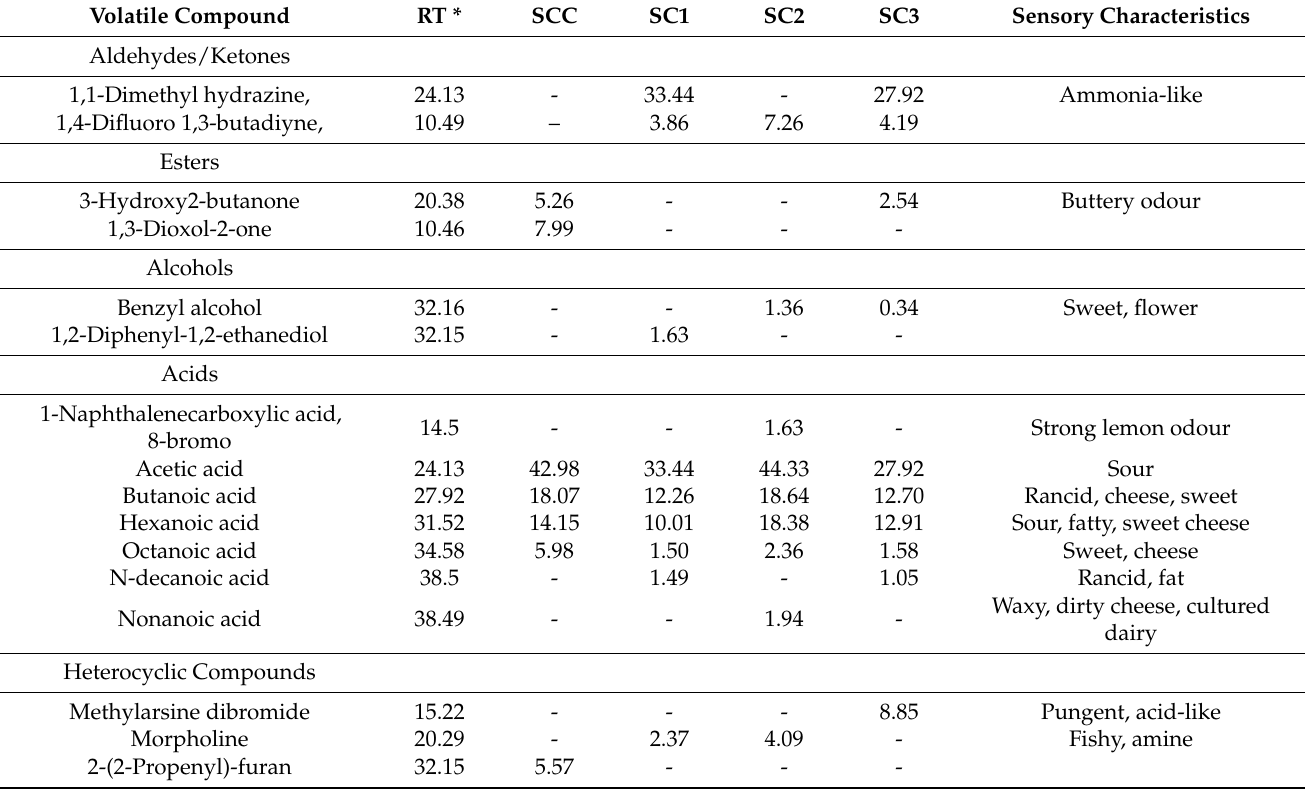
Table 8. The percentage of volatile compound peak areas in the experimental samples with sour